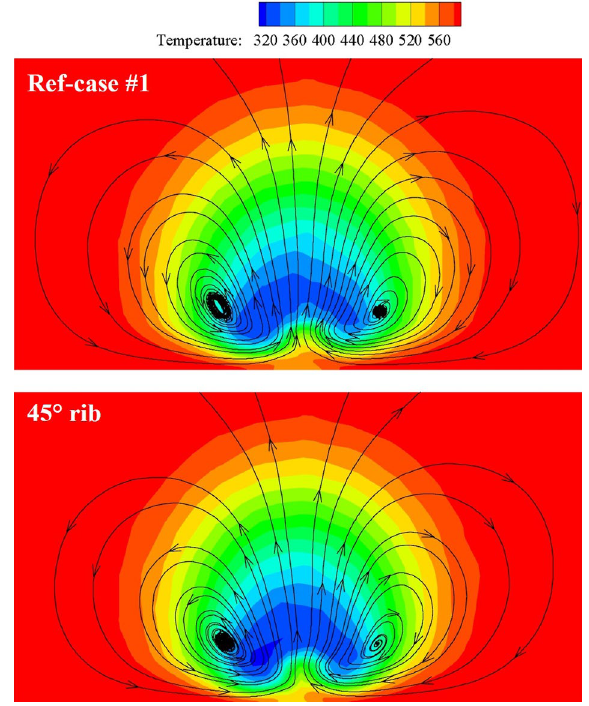
Figure 18. Temperature distribution and streamlines at slice x / D = 6.5.